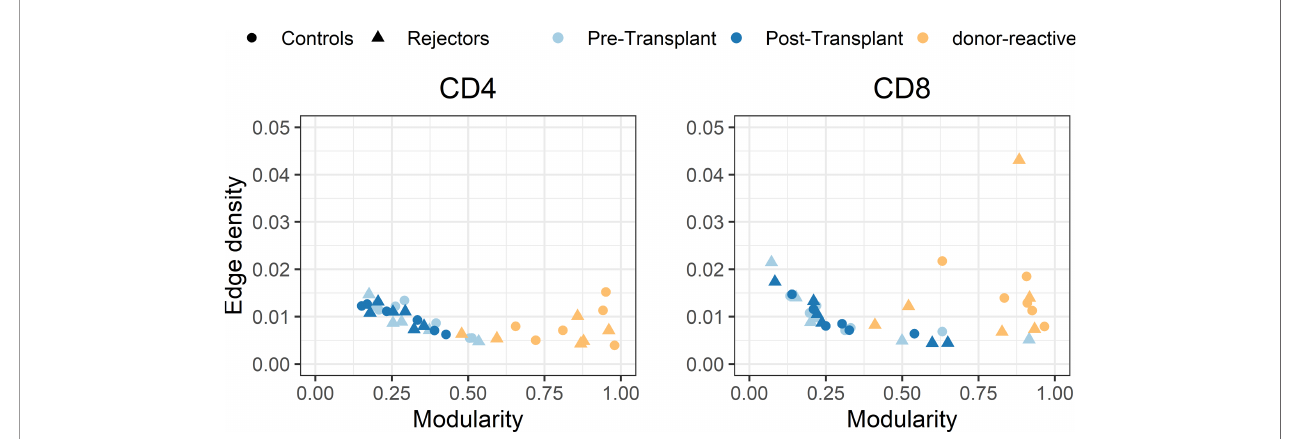
FIGURE 7 | Scatterplot of edge density (%) and modularity of the individual-speci fi c immune repertoire networks for CD4- and CD8-positive T-cells. The donor- reactive TCR repertoires (yellow) showed a signi fi cantly higher modularity assessed by paired Student ’ s t-test (p < 0.001) than the networks of the pre- and post- transplant bulk repertoires combined with comparable edge density across repertoires, suggesting a denser internal connectivity within the given